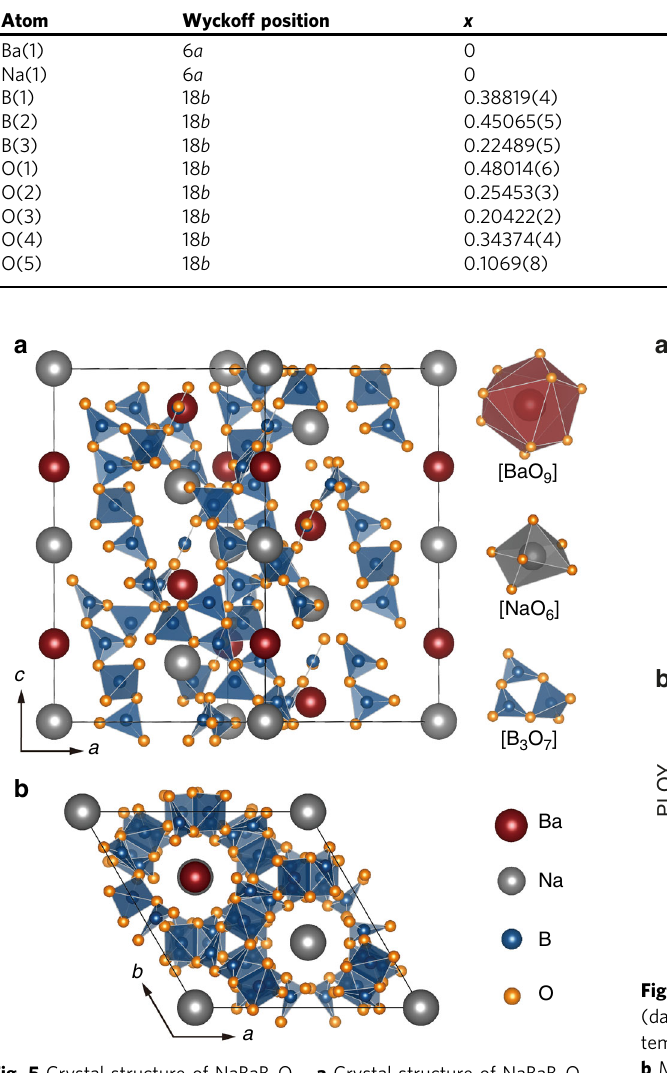
Fig. 5 Crystal structure of NaBaB 9 O 15 . a Crystal structure of NaBaB 9 O 15 viewed in [010] direction with the associated [BaO 9 ], [NaO 6 ], and [B 3 O 7 ] polyhedral subunits highlighted. b The arrangement of the [B 3 O 7 ] 5 – units generates large tunnels along the [001] direction, which are alternately fi lled by Ba 2 + and Na +